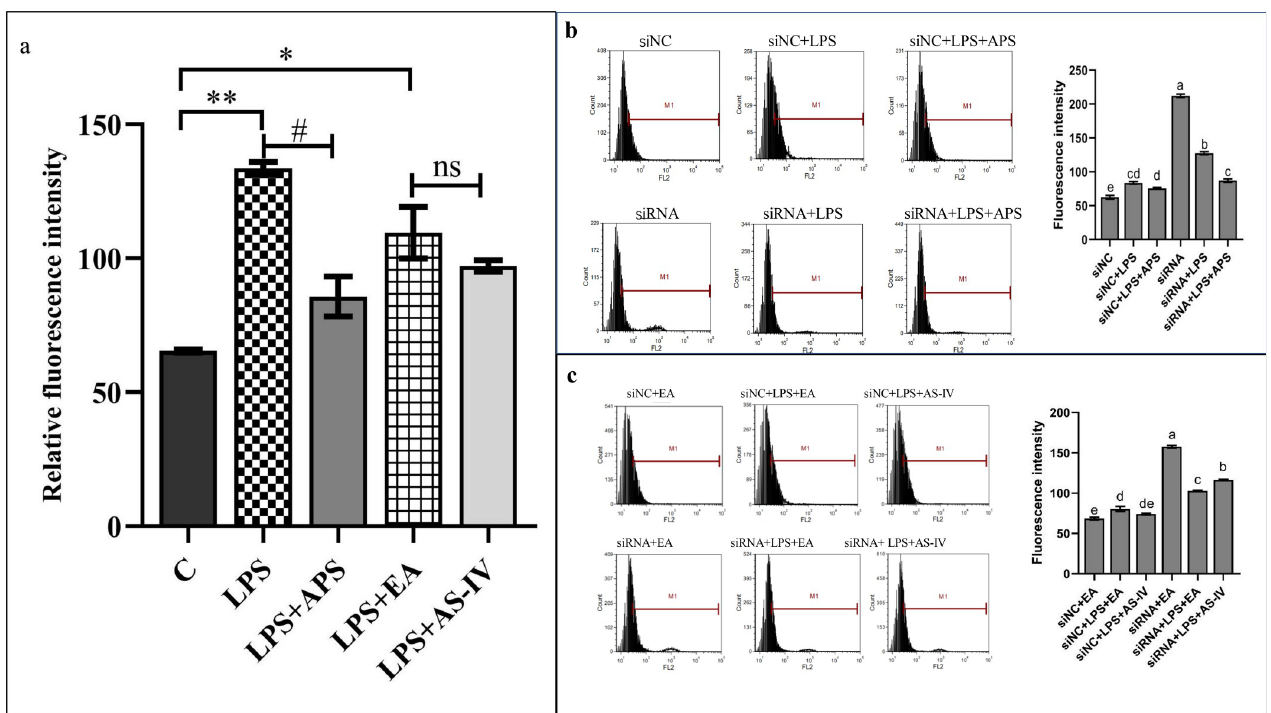
Fig 6. APS and AS-IV regulate the accumulation of ROS in BMECs under an inflammatory state. (a) APS and AS-IV inhibit the LPS-stimulated accumulation of ROS in LPS-stimulated BMECs. (b, c) Effect of APS and AS-IV on the accumulation of ROS in LPS-stimulated BMECs after silencing β - catenin. Each experimental group expresses the same meaning as in Fig 5. Data are expressed as the mean ± SD of 3 independent experiments. � , # represents 0.01 < P < 0.05, �� , ## represents P < 0.01, ns represents P > 0.05, and letter differences in the graphs indicate significant P < 0.05 differences between groups.